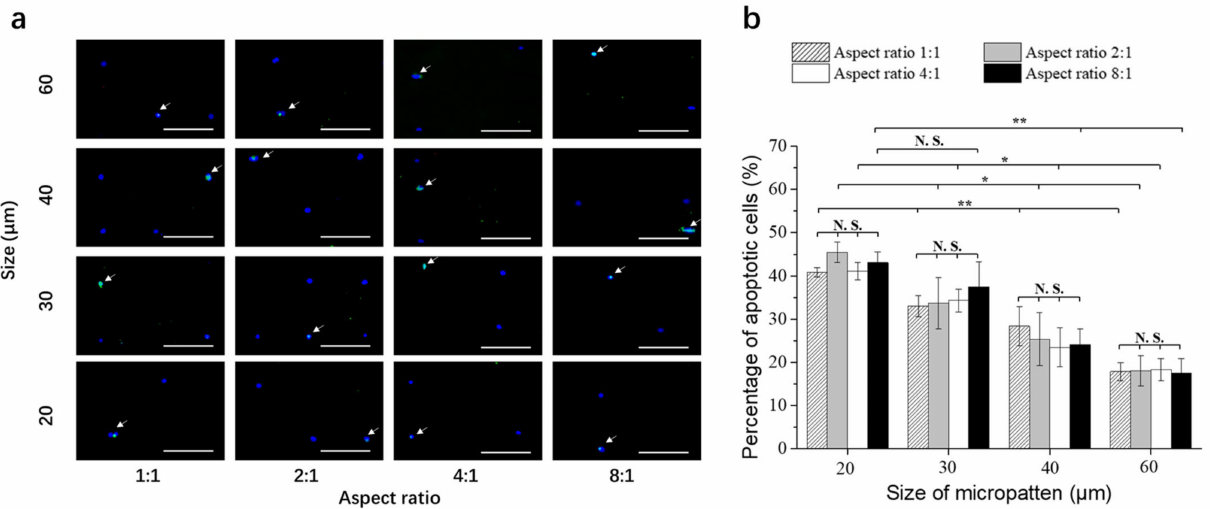
Figure 4. ( a ) Representative fluorescence images of the stained breast cancer cells on the micropat- terned surfaces. Apoptotic cells were stained green, and nuclei were stained blue. Scale bar = 200 µ m. ( b ) Percentage of apoptotic cells after culture on the micropatterned surfaces in doxorubicin- containing medium for 3 days. Data are represented as the means ± SDs ( n = 3), N.S. means no significant difference, * p < 0.05, ** p <